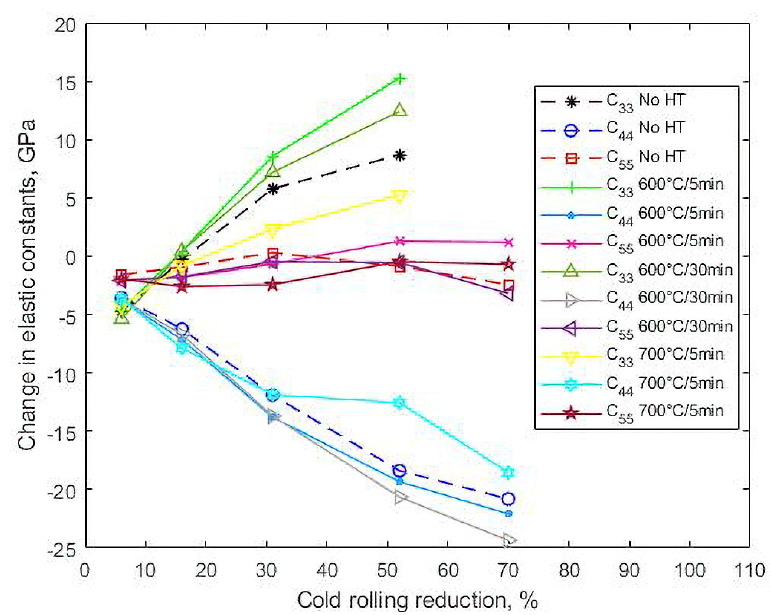
Figure 8. Cold rolling and annealing-induced shift in C 33 , C 44 and C 55 from their original values before cold rolling. As reference, data for specimens without heat treatment (dash lines, No HT) are also shown.